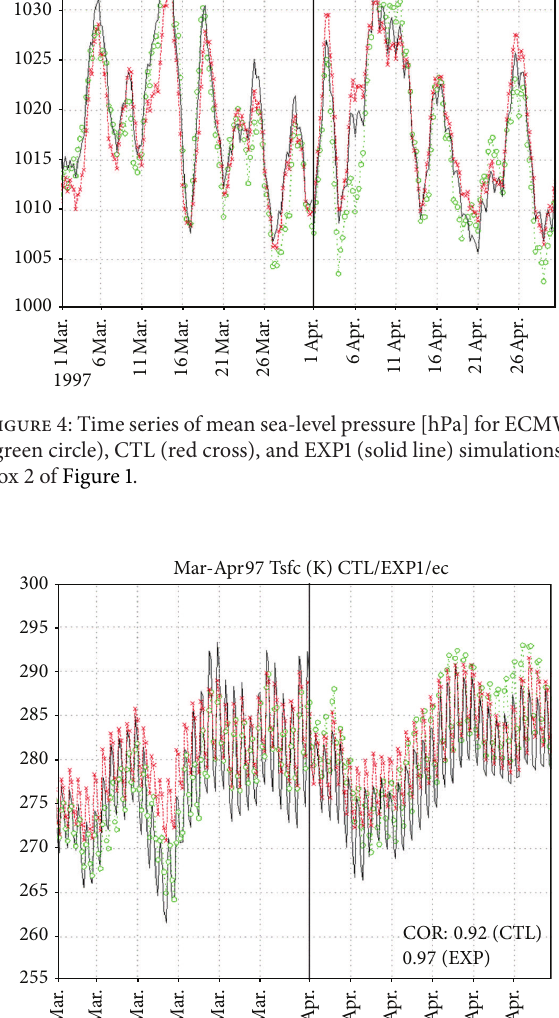
both temperature and moisture. Higher surface albedo and initial frozen soil in EXP1 cool and dry the lower atmosphere over the whole domain (Figure 6(a)). Geopotential height difference also shows a significant reduction of the height field for EXP1 (Figure 6(b)). In the atmosphere, the variation of geopotential depends on the temperature, and geopotential height decreases more rapidly in a cold layer than in a warm layer. Therefore, there is a gradual decrease in EXP1 height field up to 200 hPa because the air column below is colder when compared to